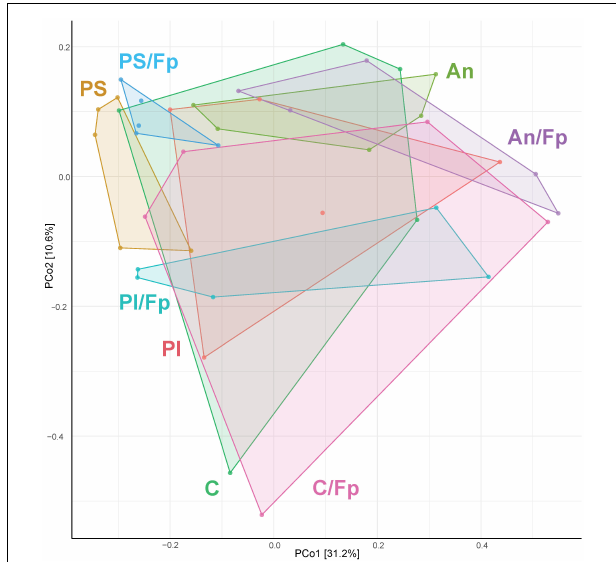
FIGURE 10 | PCoA of 40 samples and 448 OTUs (33 dpi) [The OTUs were transformed to relative abundance]. Prior to the analysis, OTU’s that are not present in more than 0.1% relative abundance in any sample have been removed. No initial data transformation has been applied. The relative contribution (eigenvalue) of each axis to the total inertia in the data is indicated in percent at the axis titles. C, control feed group; An, antibiotic feed group; PI, phage-immobilized feed group; PS, phage-sprayed feed group; C/Fp, control feed group + F. psychrophilum ; An/Fp, antibiotic feed group + F. psychrophilum ; PI/Fp, phage-immobilized feed group + F. psychrophilum ; PS/Fp, phage-sprayed feed group + F.